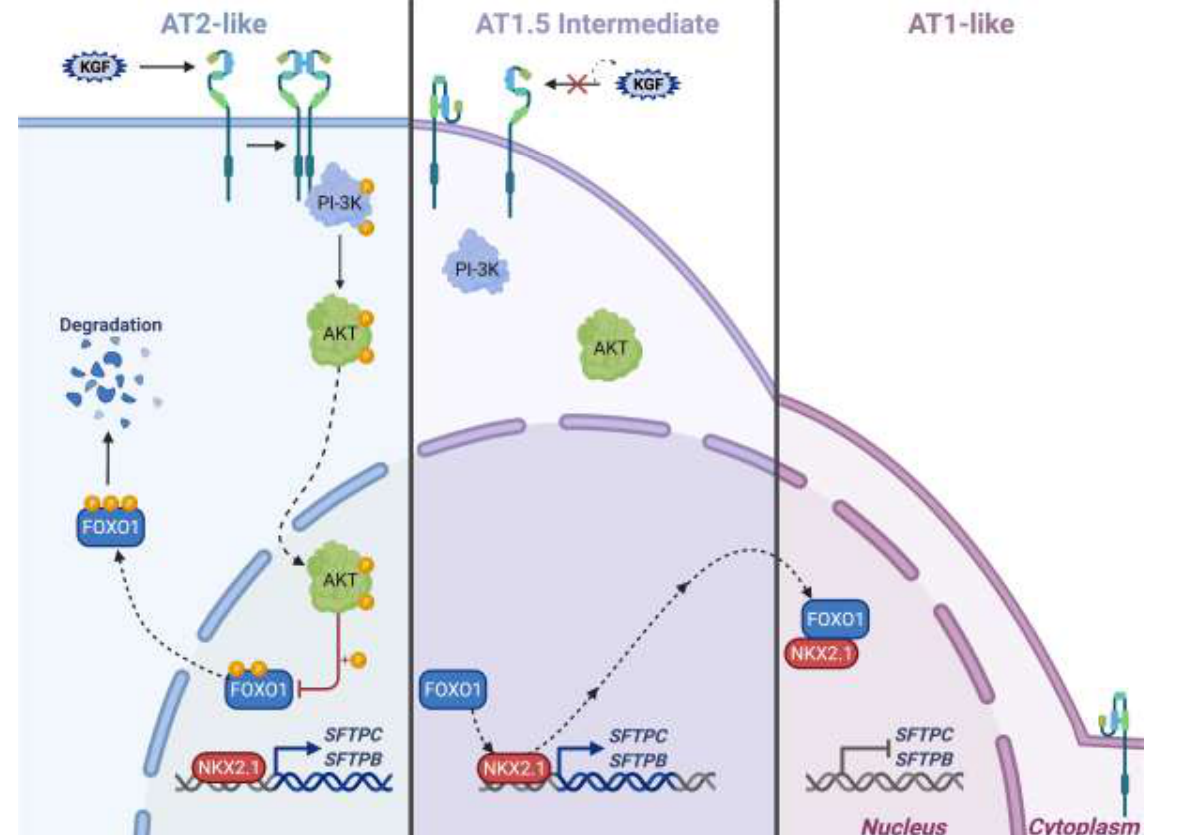
Figure 6. Model of mechanisms underlying FOXO1 regulation of lung-specific NKX2.1-activated genes via PI-3K/AKT-dependent phosphorylation. In AT2 and AT2-like cells in the presence of KGF, the PI-3K/AKT pathway is activated, leading to downstream phosphorylation of FOXO1 and subsequent cytoplasmic extrusion and degradation. The absence of nuclear FOXO1 allows active NKX2.1 to remain at the SFTPC and SFTPB promoters, increasing the expression of these AT2 cell-specific target genes. During the transition from AT2 to AT1-like cells (AT1.5 intermediate cells), or in the absence of KGF, the PI-3K/AKT pathway becomes inactivated. This in turn prevents the phosphorylation of FOXO1, allowing it to remain in the nucleus and interact with and pull NKX2.1 from its target promoters. This process is completed in differentiated AT1-like cells, where NKX2.1 removal from target genes by FOXO1 leads to the inhibition of gene expression. The figure was created with BioRender (BioRender Academic License https://biorender.com/ (accessed on 14 March 2022)).